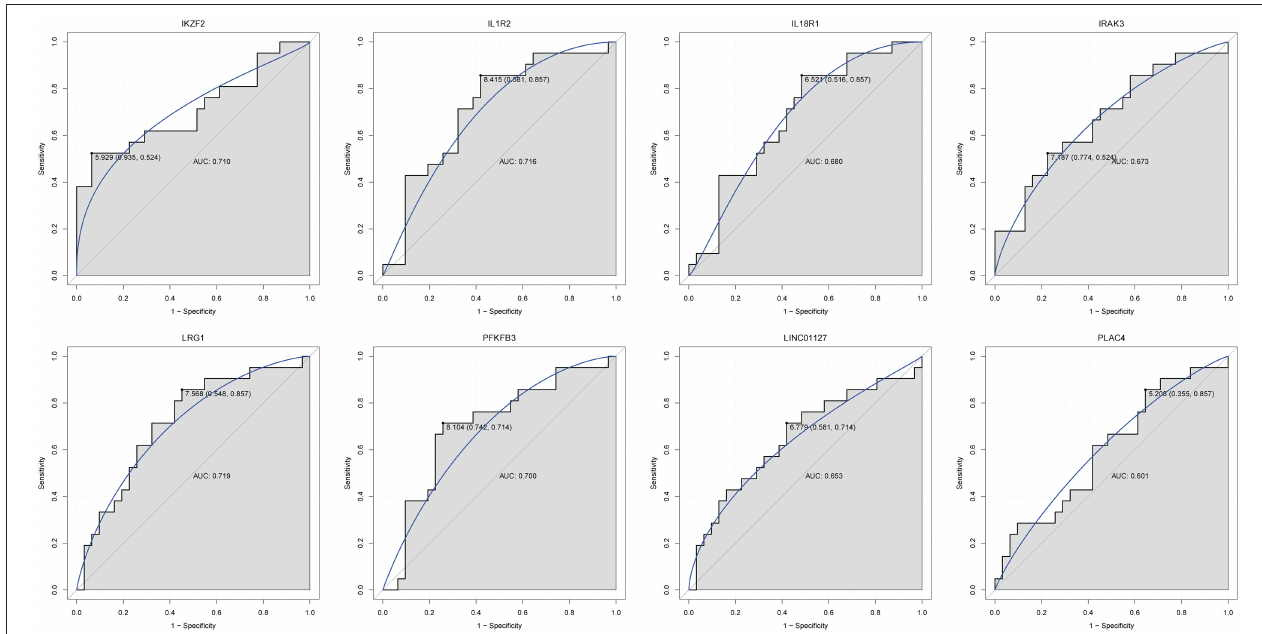
FIGURE 9 | The ROC curves of IKZF2, IL1R2, IL18R1, IRAK3, LRG1, PFKFB3, LINC01127, and PLAC4 in AMI. The ROC curves were used to show the diagnostic ability with 1 – specificity and